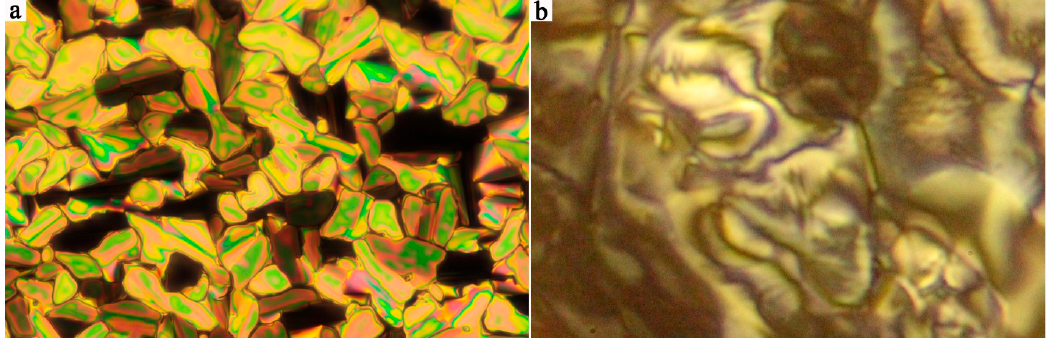
Figure 2. ( a ) Planar texture of Ia in the B 1 phase at T = 115 °C, the width of the photo is about 200 μ m. ( b ) Sample with free upper surface with a schlieren texture for Ic in the SmC A P A phase at T = 92 °C. Width of the photos corresponds to 150 μ m.